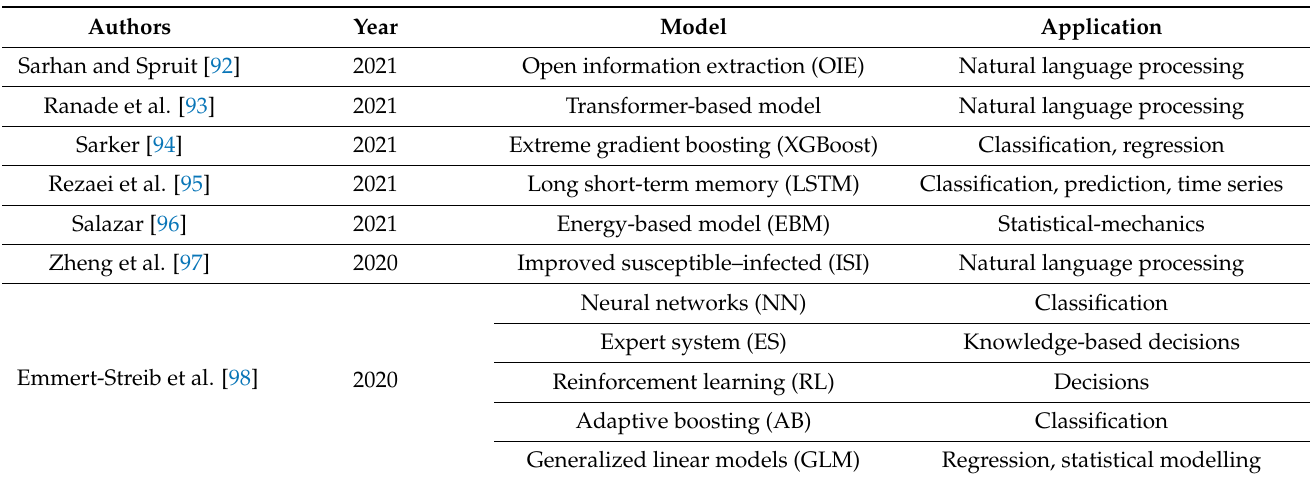
Table 9. List of some selected trends for artificial intelligence